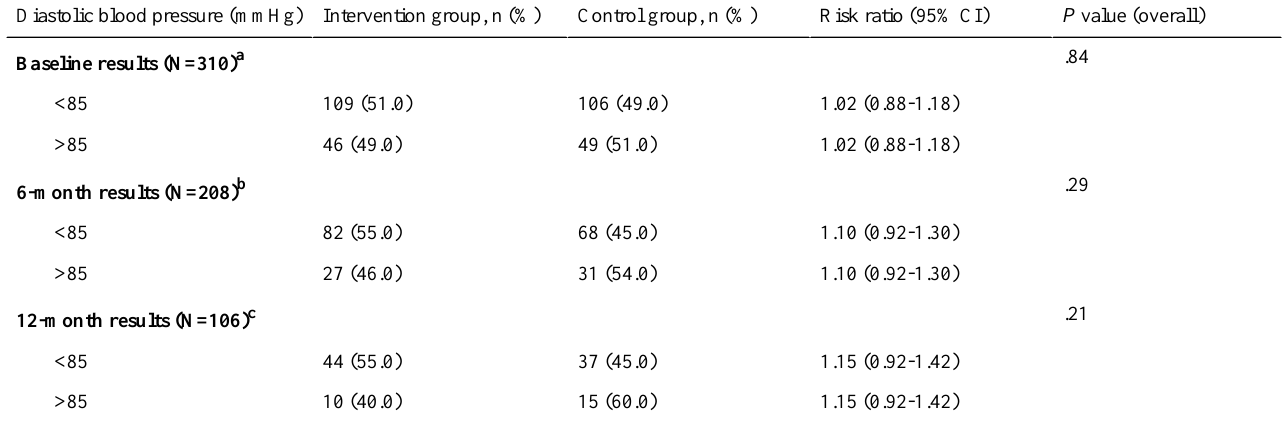
Table 3. Diastolic blood pressure.